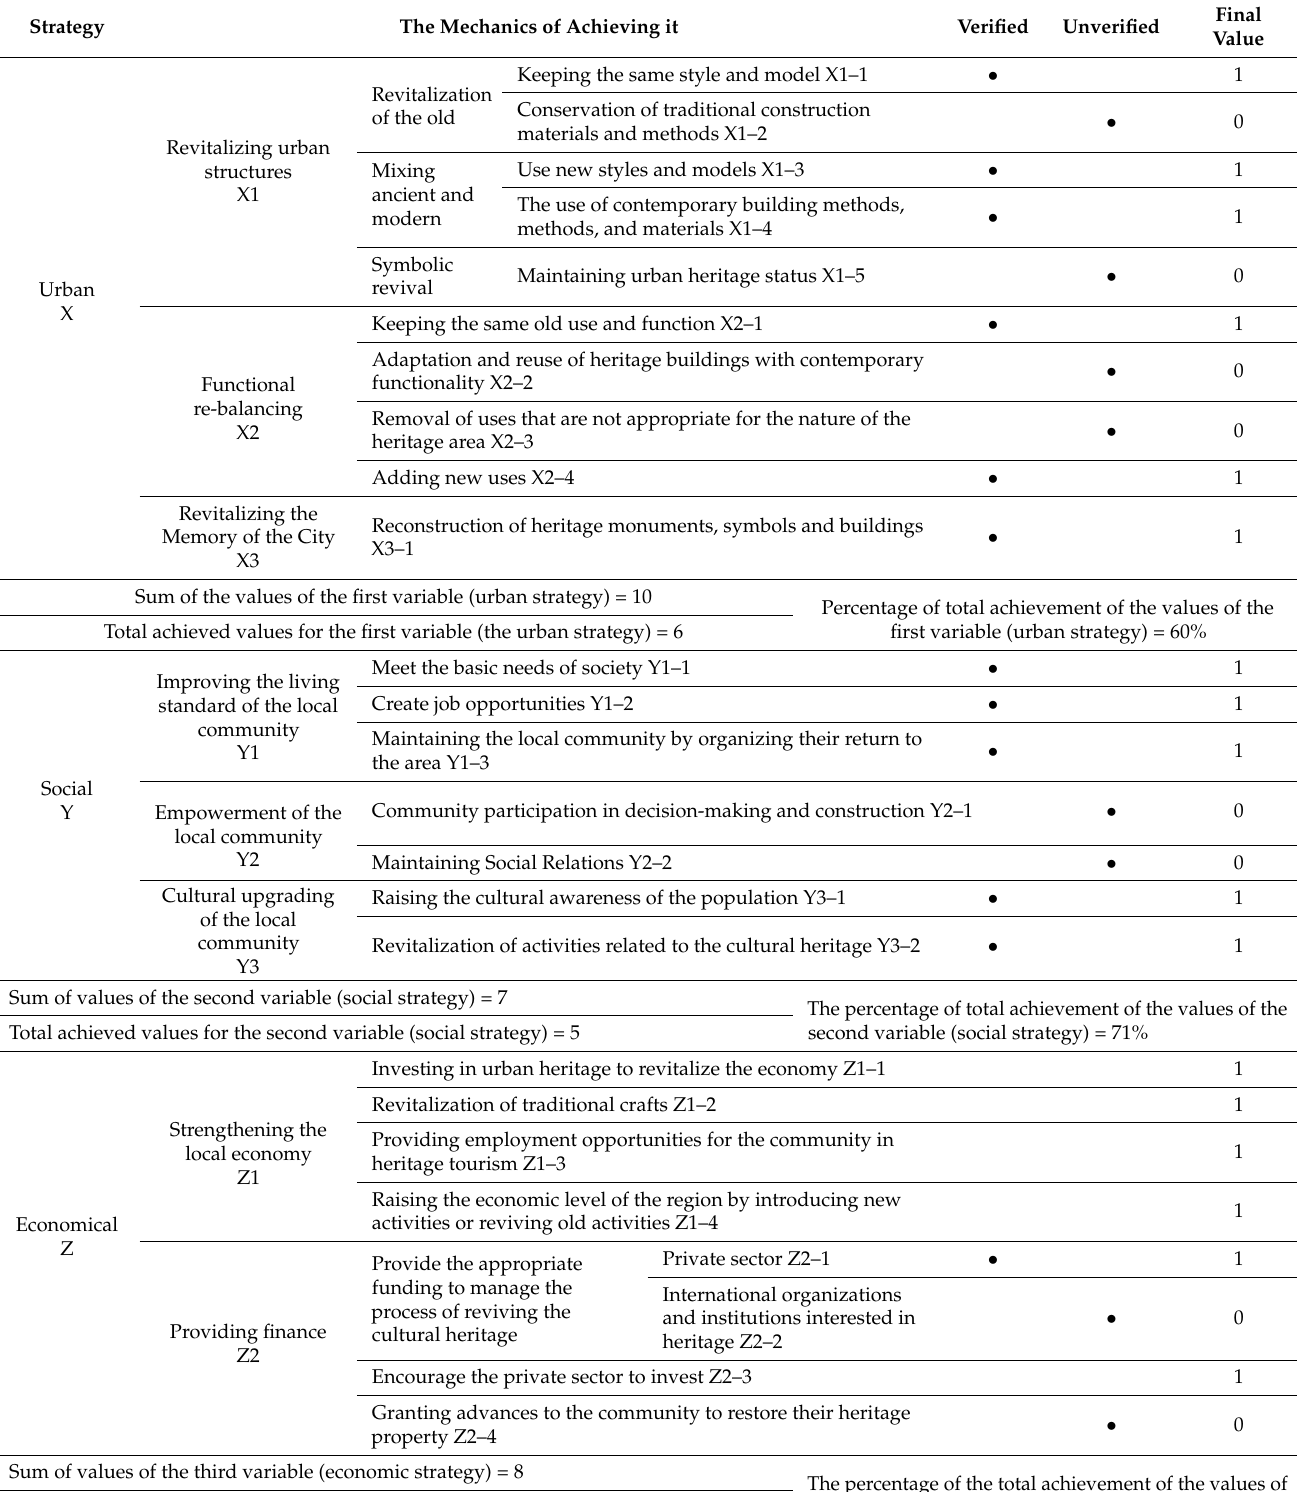
Table 4. The most important indicators extracted for the revival of cultural heritage after war. Project